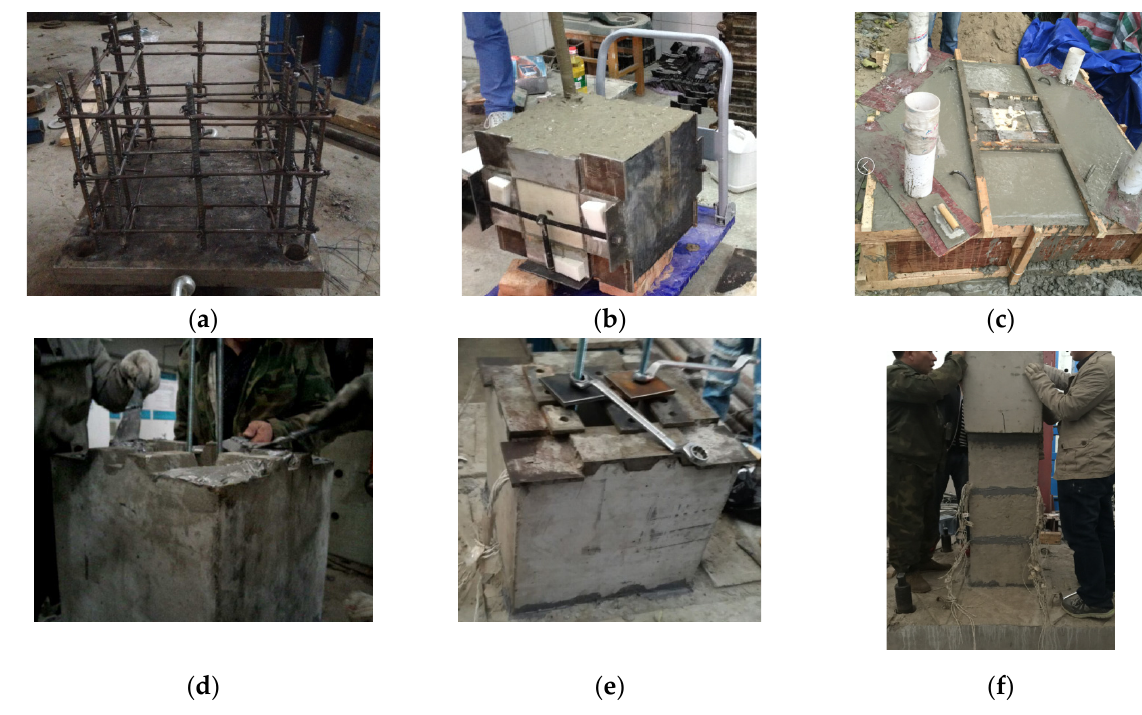
Figure 3. Fabrication process. ( a ) Tying of reinforcement cage. ( b ) Pouring sections. ( c ) Pouring bearing platform. ( d ) Contact surface gluing. ( e ) Extrusion bonding surface. ( f ) Section assembly.